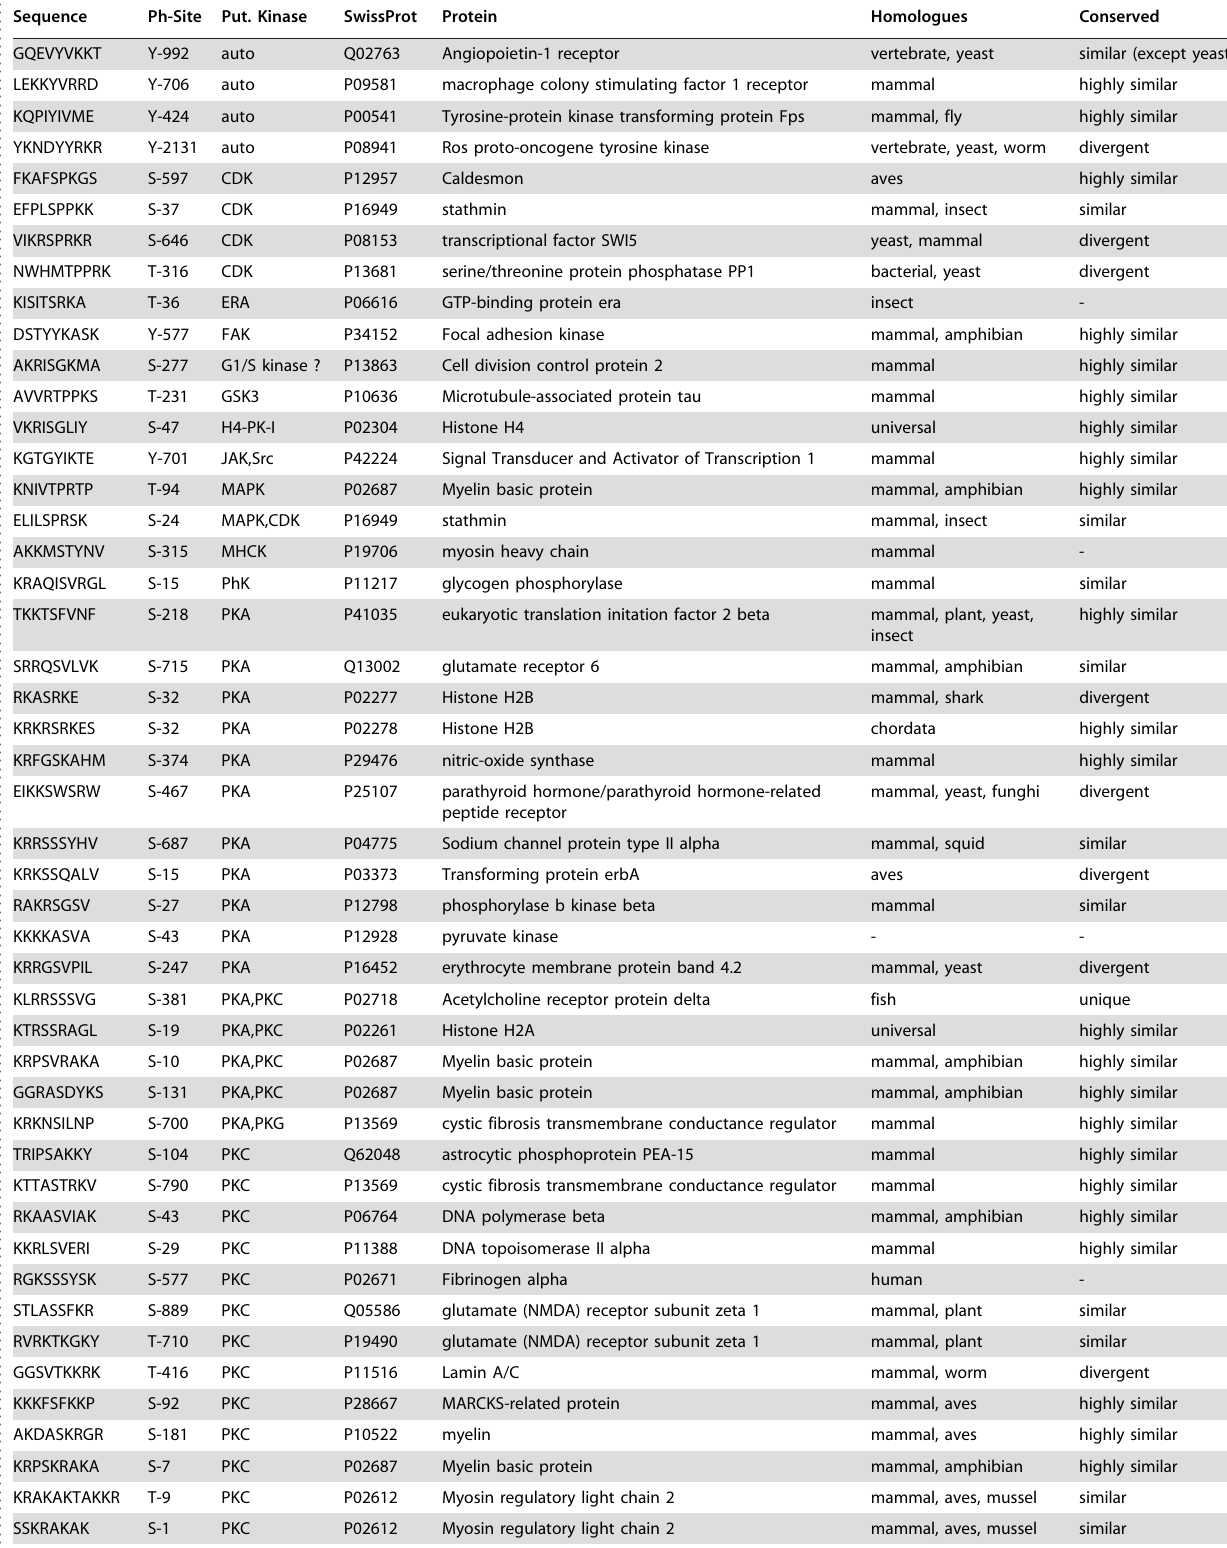
Table 3. Unique substrates phosphorylated in the majority of the profiles tested (supplementary info). Distribution in other species and the conservation of each substrate are also indicated. .. ... .... ... ... .... ... ... .... ... ... .... ... ... .... ... ... .... ... ... .... ... ... .... ... ... .... ... ... .... ... ... .... ... ... .... ... ... .... ... ... .... ... ... . Sequence Ph-Site Put.